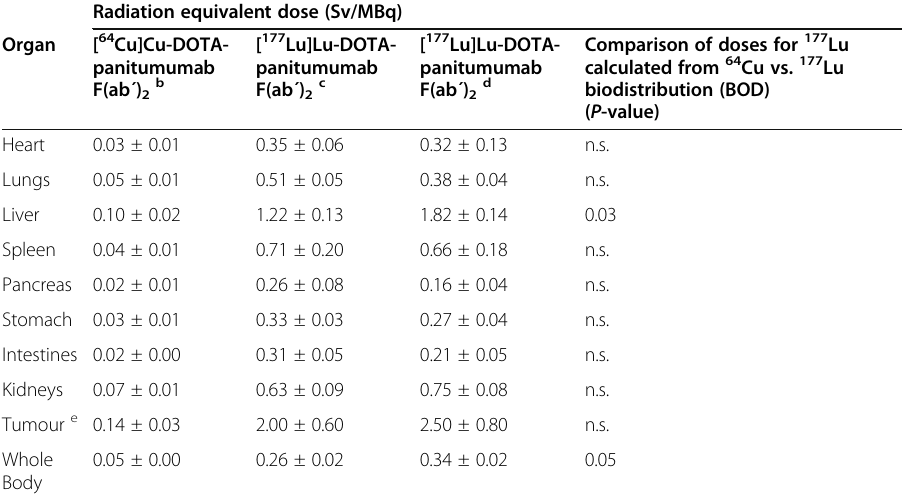
Table 3 Radiation equivalent doses in the tumour and normal organs for radioimmunoconjugates in NRG mice with s.c. HNSCC primary xenografts